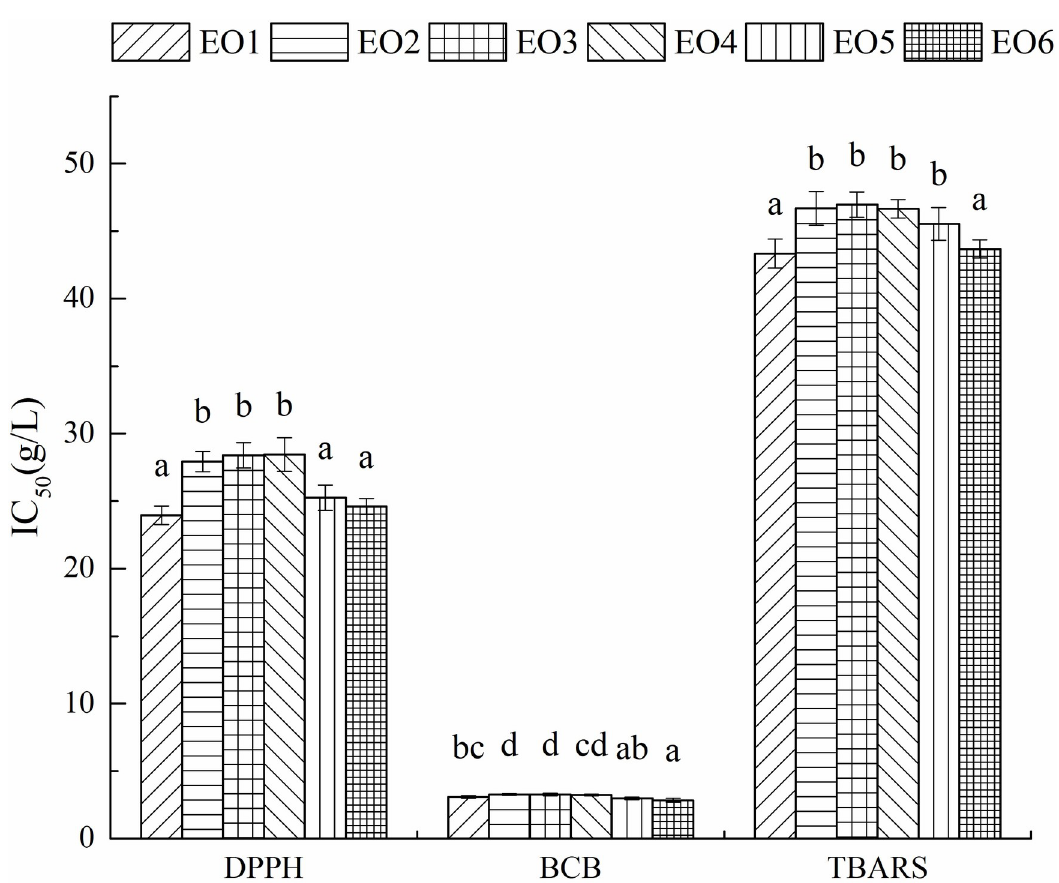
Fig 6. IC 50 values for antioxidant activities of six